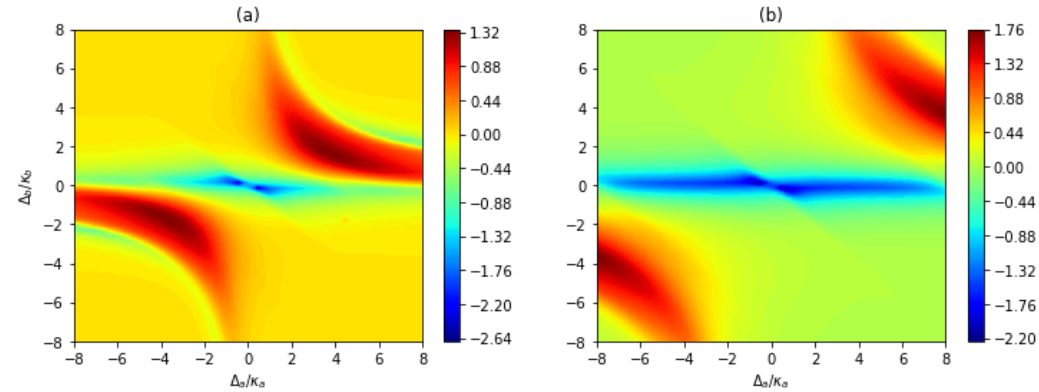
Figure 6. The equal-time second-order correlation function